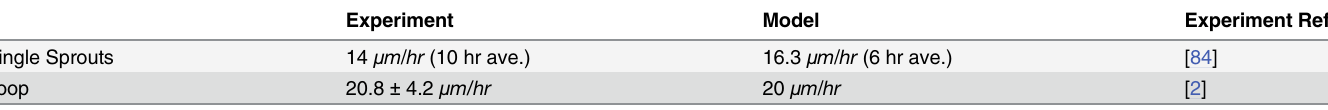
Table 3. Average extension speeds of single sprouts and